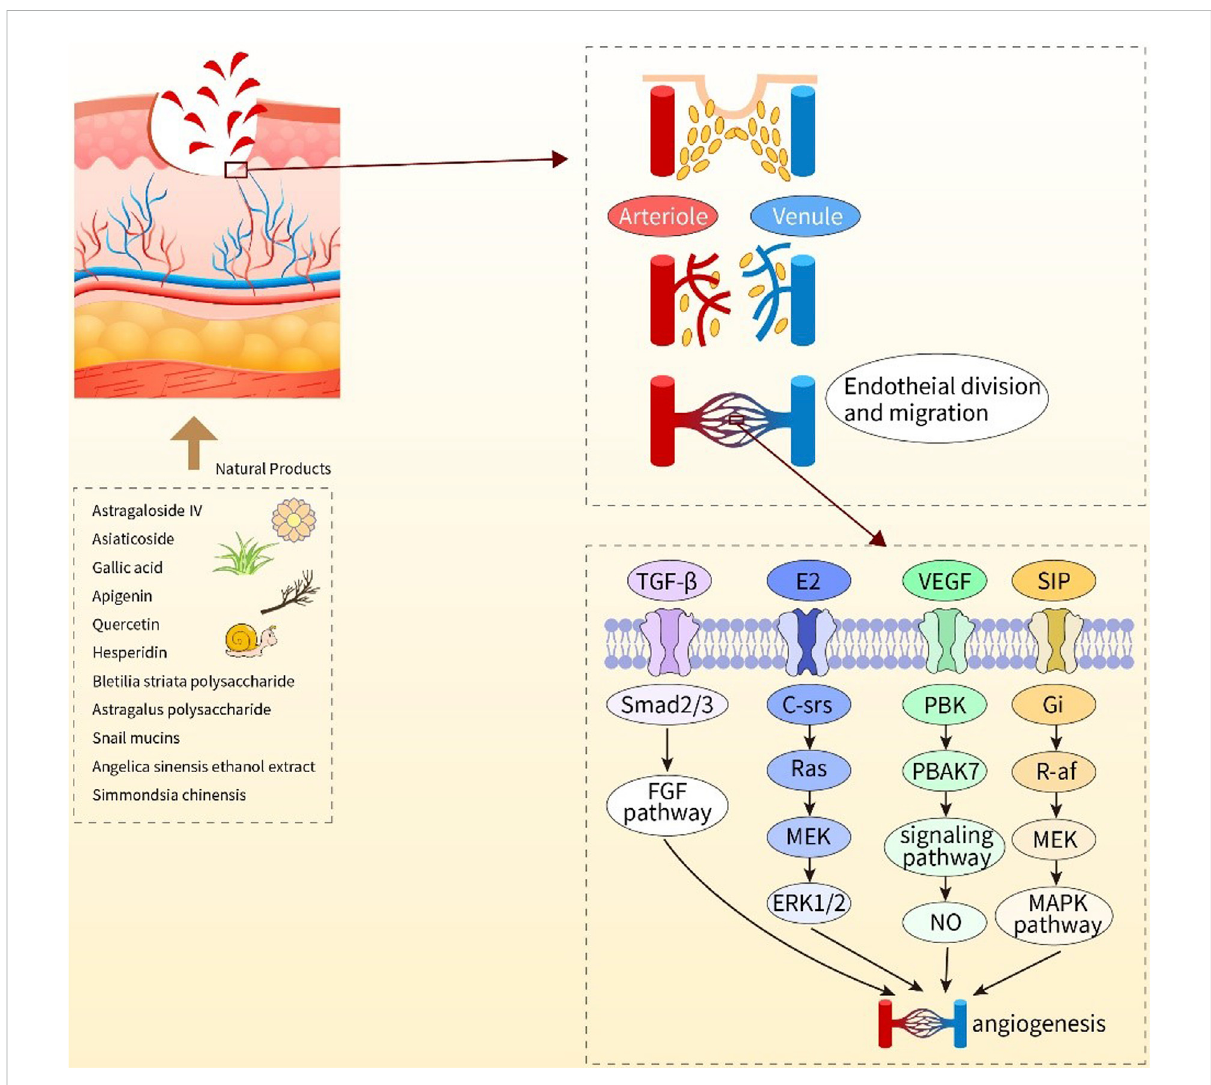
FIGURE 3 Diagram of the mechanisms of action of natural products to promote angiogenesis. Astragaloside IV, asiaticoside, gallic acid, apigenin, quercetin, hesperdin, bleilia striata polysaccharide, astragalus polysaccharide, snail mucins, angular sinensis ethanol extract, Simmondsia chinensis, the above 11 natural products play a positive role in wound healing by promoting